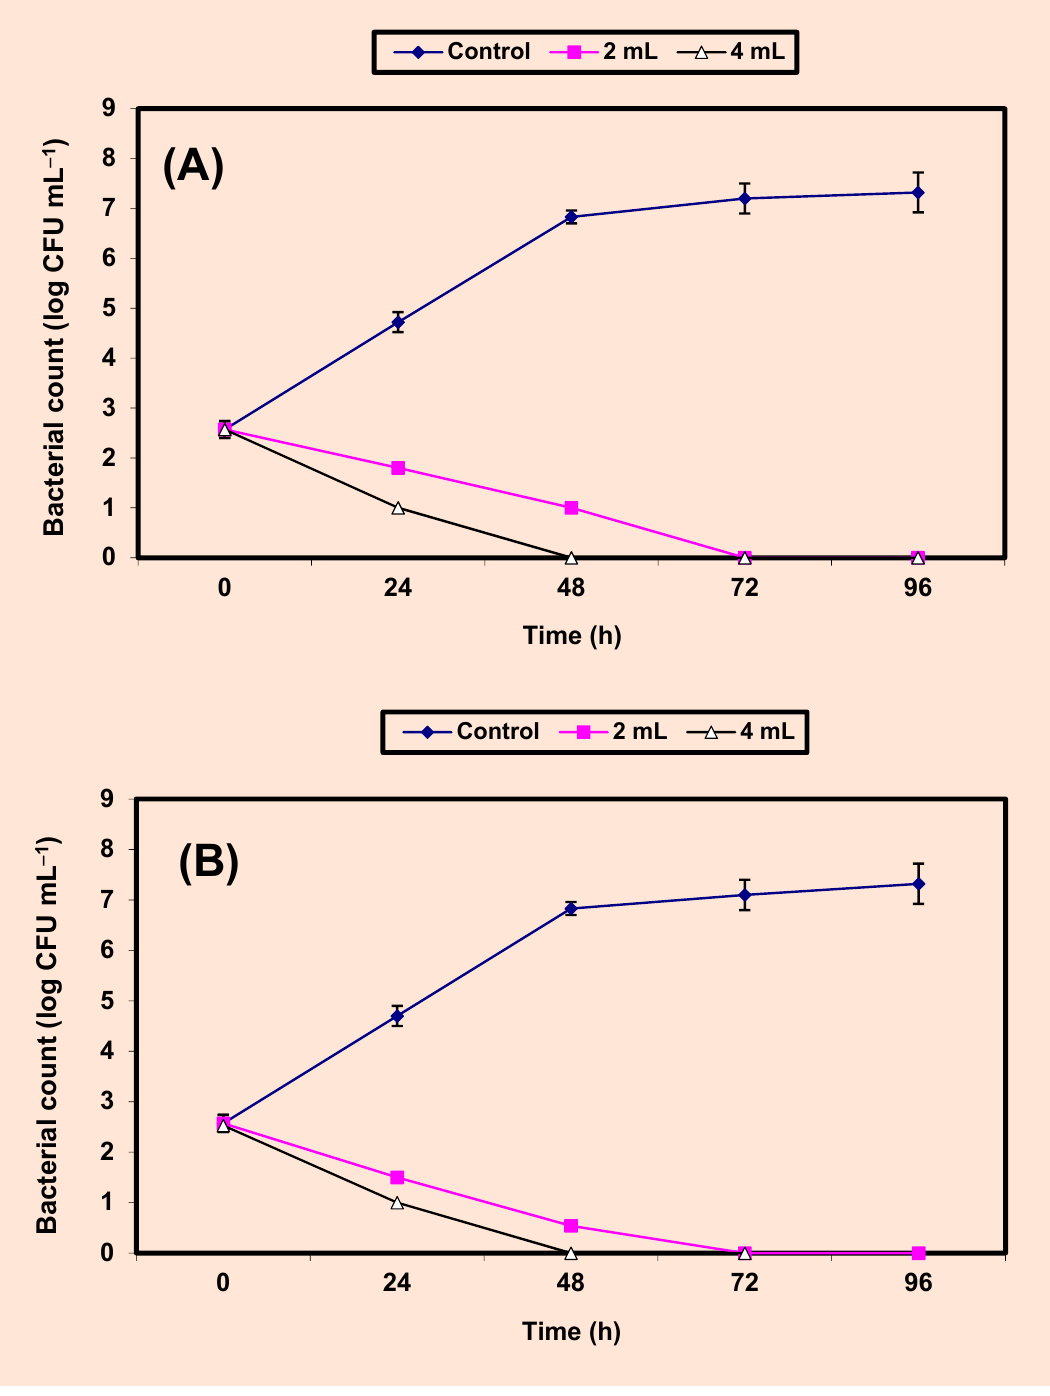
Figure 7. Inhibition of both S. aureus ( A ) and Sal. typhimurium ( B ) in tomato juice. Symbols ♦ , ■ , ∆ , refer to control untreated samples, samples treated with 2%, 4% KB, respectively.